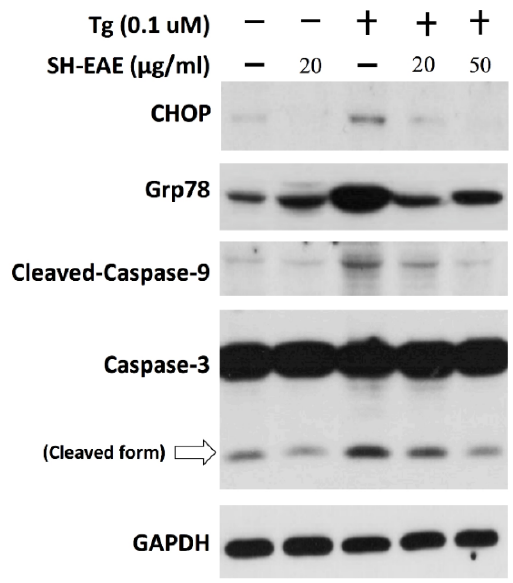
Figure 8. SH ‐ EAE abrogated the Tg ‐ mediated induction of Grp78 and CHOP expression. H1299 cells were pretreated with SH ‐ EAE for 10 h and further treated with Tg for another 12 h. Protein lysates were subjected to SDS ‐ PAGE followed by immunoblotting using antibodies against Grp78, CHOP, cleaved ‐ caspase ‐ 9 and caspase ‐ 3. H1299 cells pretreated with 20 and 50 μ g/mL SH ‐ EAE were significantly inhibited by Tg ‐ induced CHOP expression. α‐ tubulin served as the loading